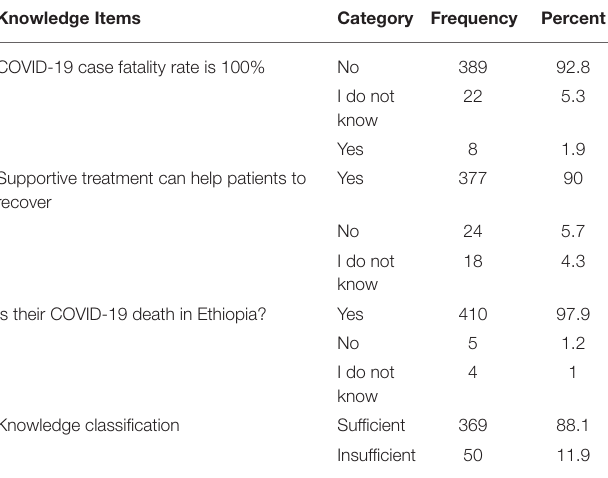
TABLE 3 | Health professionals’ attitude toward COVID-19 in Dessie city, northeast Ethiopia ( N =